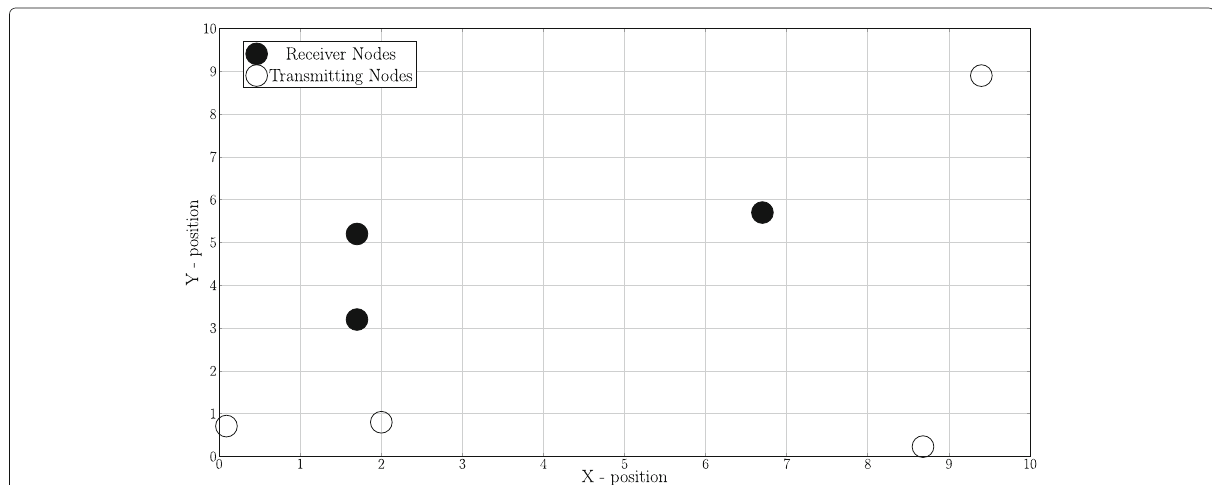
Fig. 5 Network example. Sensor network example with four transmitters in white and three receivers in black. Receivers generate feedback to provide transmitters with imperfect